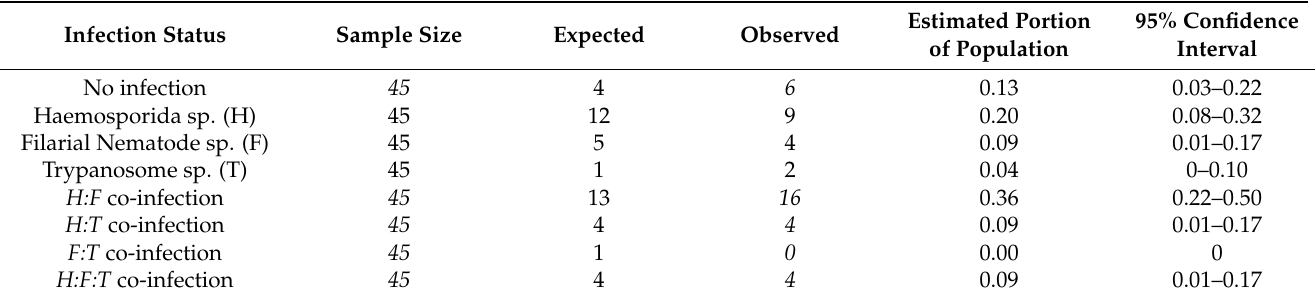
Table 2. Co-infection of great-tailed grackles ( Quiscalus mexicanus ), College Station, Texas,